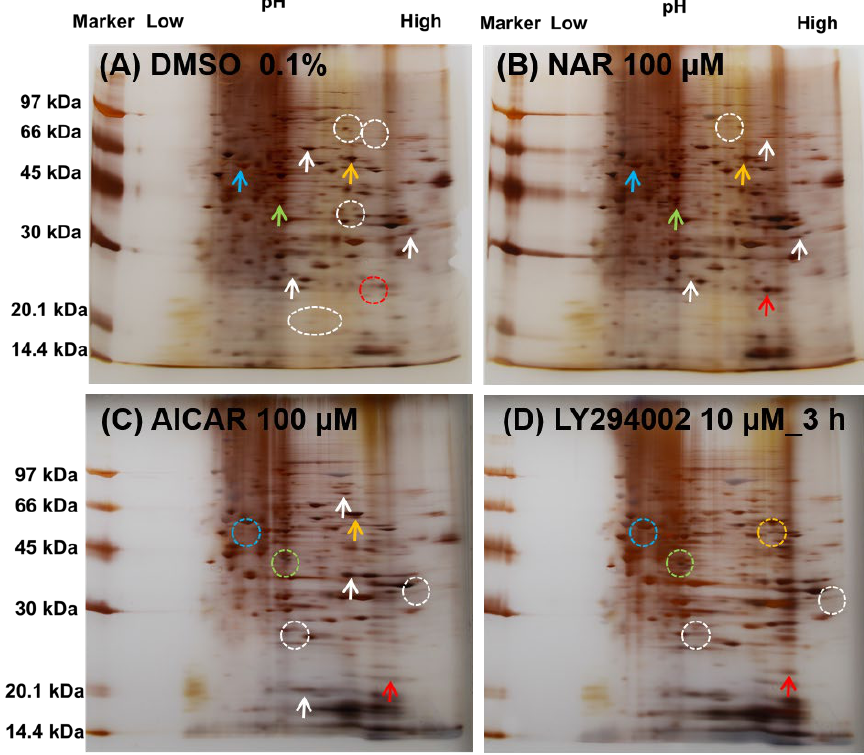
Figure 8. Protein expression profiling of NAR-, AICAR- and LY294002-treated MDCK II cells. Cells were treated with NAR (100 μM) ( B ) or AICAR (100 μM) for 48 h ( C ) or LY294002 (10 μM) for 3 h ( D ) and DMSO is used for control ( A ). Decreased or vanished protein spots were marked with broken line circles, and increased spots were marked with arrows. Red: weak at DMSO, and increased at NAR, AICAR and LY294002; orange: weak at DMSO and LY294002, and increased at NAR and AICAR; pea green and sky blue: increased at DMSO and NAR, and vanished at AICAR and LY294002. The predicted candidate of each protein is summarized in Table 1. MDCK: Madin–Darby canine kidney,